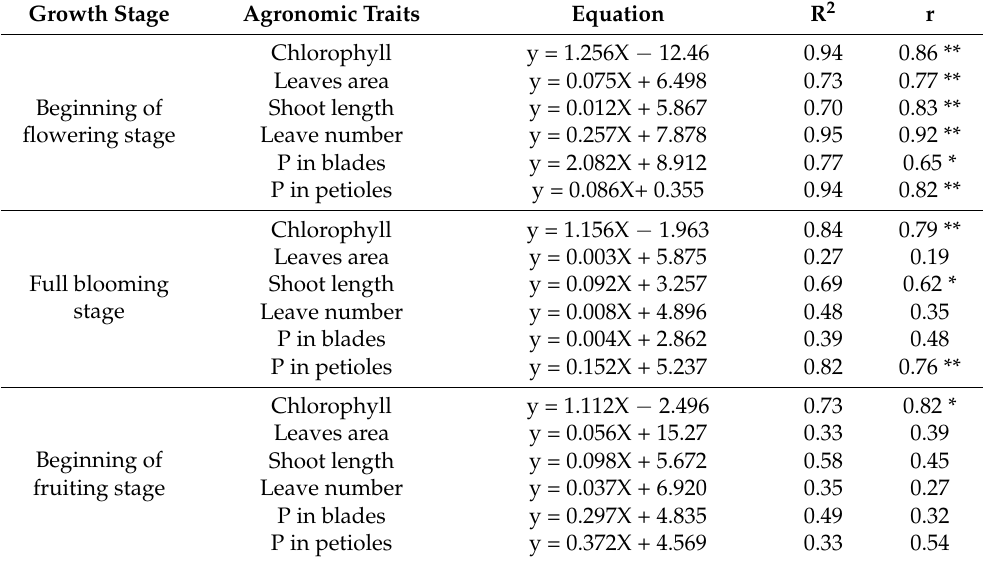
Table 4. The correlation between fruit yield of mango and some agronomic traits. The correlation analysis between fruit yield and agronomic traits was run based on the data of the four years. *, ** significant at p < 0.05 and p < 0.01. Number of samples is